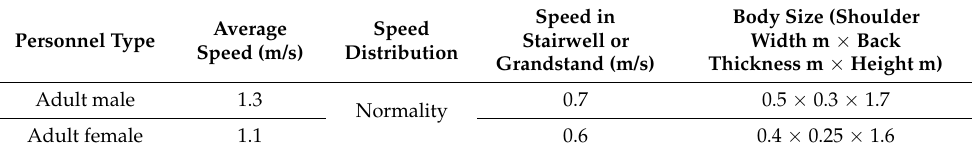
Table 9. Personnel speed and physical characteristics.